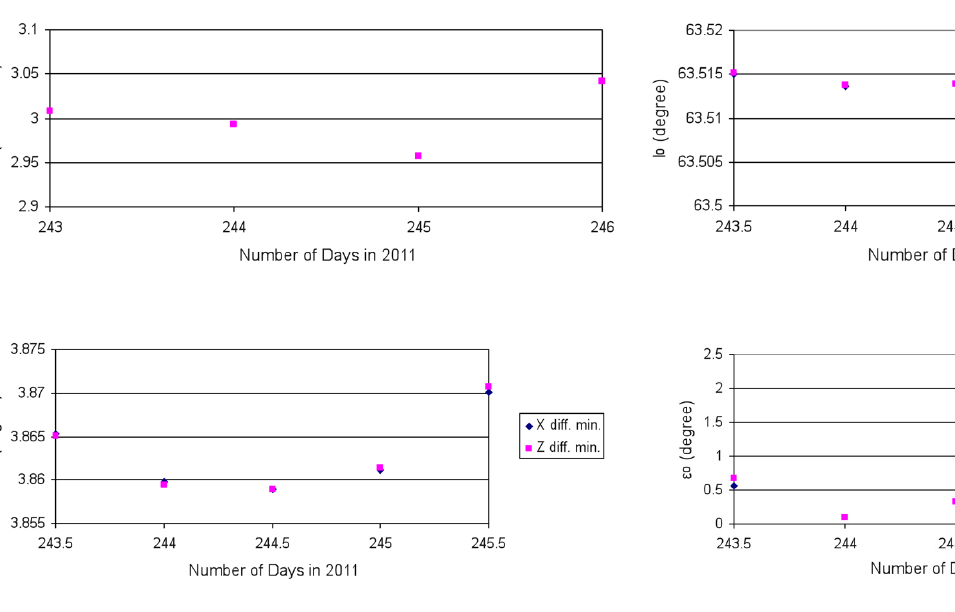
Clockwise from top left: Figure 4. The measured orthogonality error of the DIDD system; Tihany observatory 31.08.2011-02.09.2011. Figure 5. The parameter of the DIDD system computed with the conditions estimated I 0 of |X − X | < 0.1 nT (blue dots) or |Z − Z |< 0.1 nT (pink meas. comp. meas. comp. dots); Tihany observatory 31.08.2011-02.09.2011 (see text). Figure 6. The parameter of the DIDD system computed with the conditions estimated D 0 of |X − X | < 0.1 nT (blue dots) or |Z − Z |< 0.1 nT (pink meas. comp. meas. comp. dots); Tihany observatory 31.08.2011-02.09.2011 (see text). Figure 7. The estimated levelling errors of the DIDD system computed with the − X | < 0.1 nT (blue dots) or |Z − Z |< conditions of |X meas. comp. meas. comp. < 0.1 nT (pink dots); Tihany observatory 31.08.2011-02.09.2011 (see text).